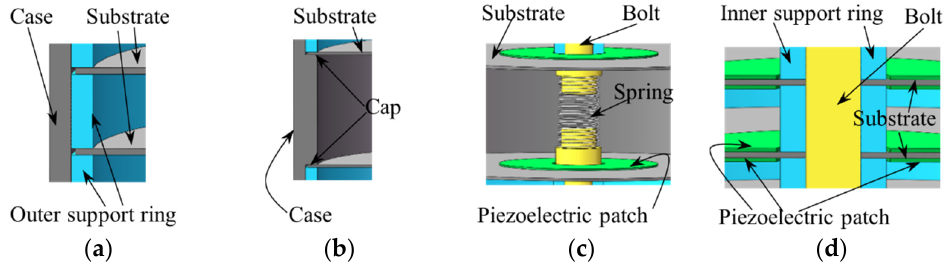
Figure 3. Local enlarged view of points A , B , C , and D in Figure 2. ( a ) Local view of point A ; ( b ) local view of point B ; ( c ) local view of point C ; ( d ) local view of point D .